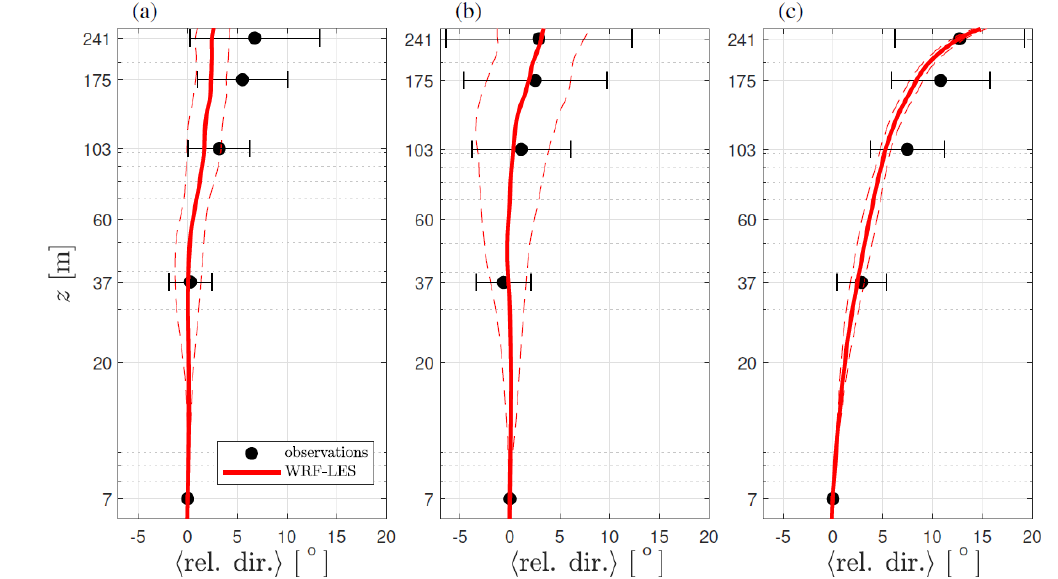
Figure 8. Observed and simulated turning of the wind for neutral (a) , unstable (b) , and stable (c) conditions. The error bars and dashed lines denote ± 1 standard deviation from the mean of the observations and simulations, respectively.